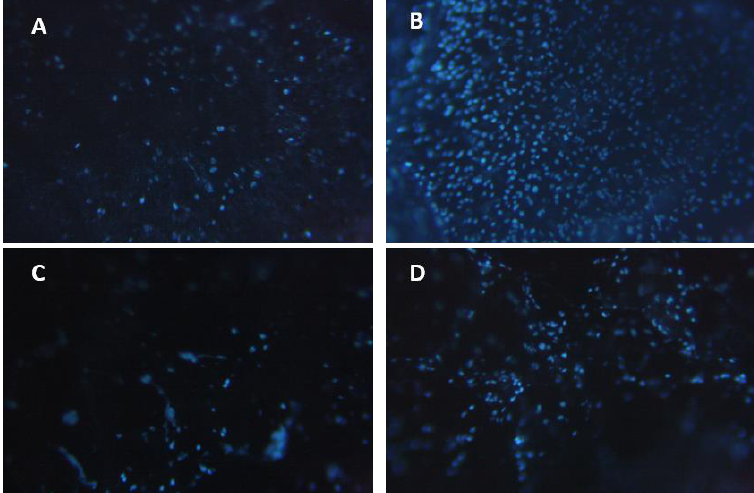
Figure 13. Cell infiltration of the CaP ( A , B ) and FeP ( C , D ) hydrogels during subcutaneous im- plantation in laboratory rats. ( A , C ) — after 1 day of implantation, ( B , D ) — after 7 days of implanta- tation in laboratory rats. ( A , C )—after 1 day of implantation, ( B , D )—after 7 days of implantation. tion. Magnification 100×. Magnification 100 ×